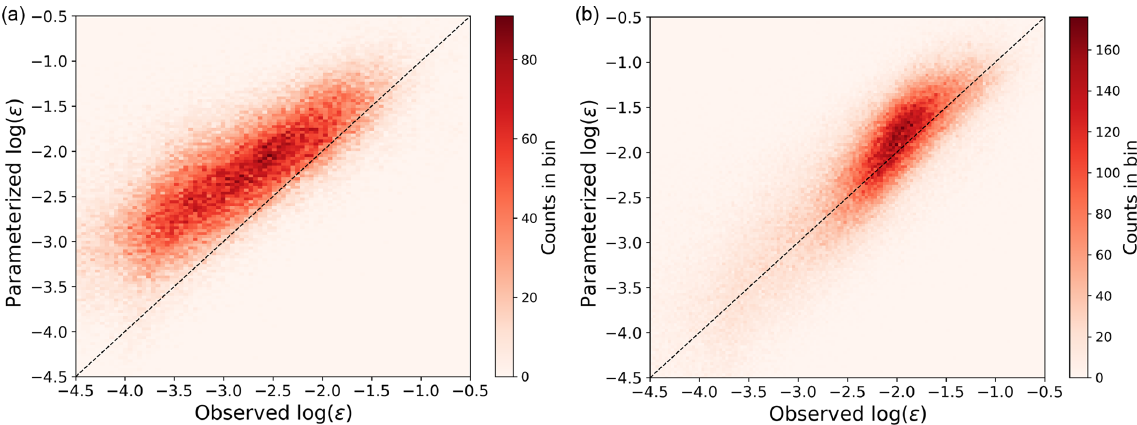
Figure 4. Scatter plot showing the comparison between observed and MYNN-parameterized (cid:15) from the 184 sonic anemometers at Perdigão for stable conditions (a) and unstable conditions (b) , as quantified by ζ = z/L calculated at each sonic anemometer.